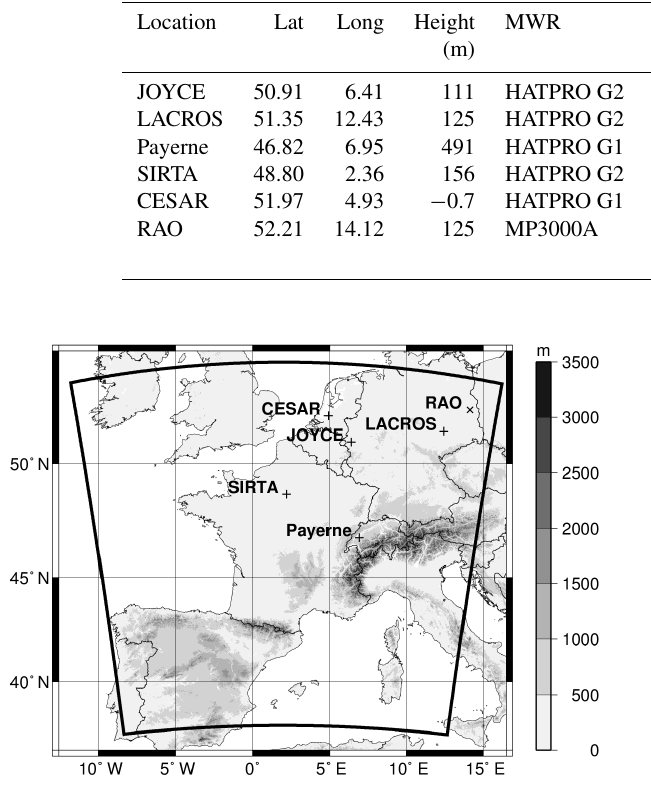
Figure 1. Topography (m) and domain of AROME-France (large area delineated by solid black line). Locations of MWR sites are also shown ( + and × indicate, respectively, HATPRO and